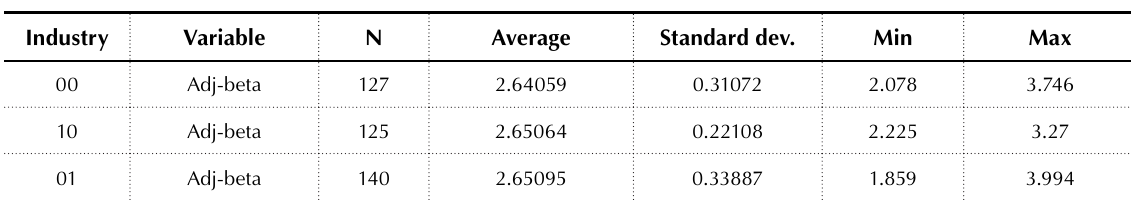
Table 1a. Descriptive statistics for cross-sectional data (average period 2012–2013) Panel A. Dependent variable